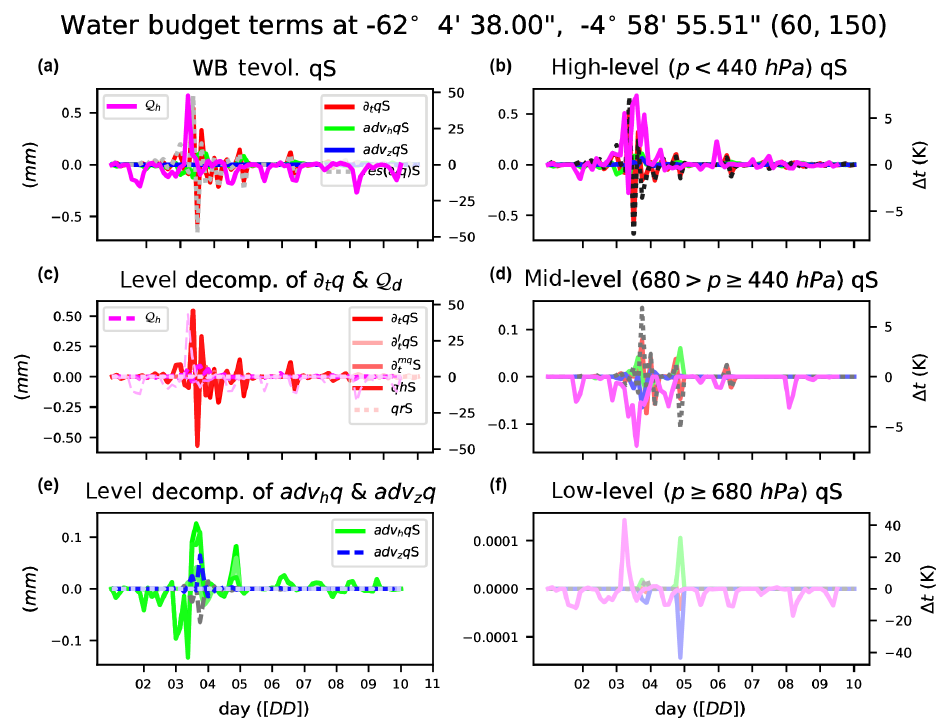
Figure 14. The same as in Fig. 12, but for snow.